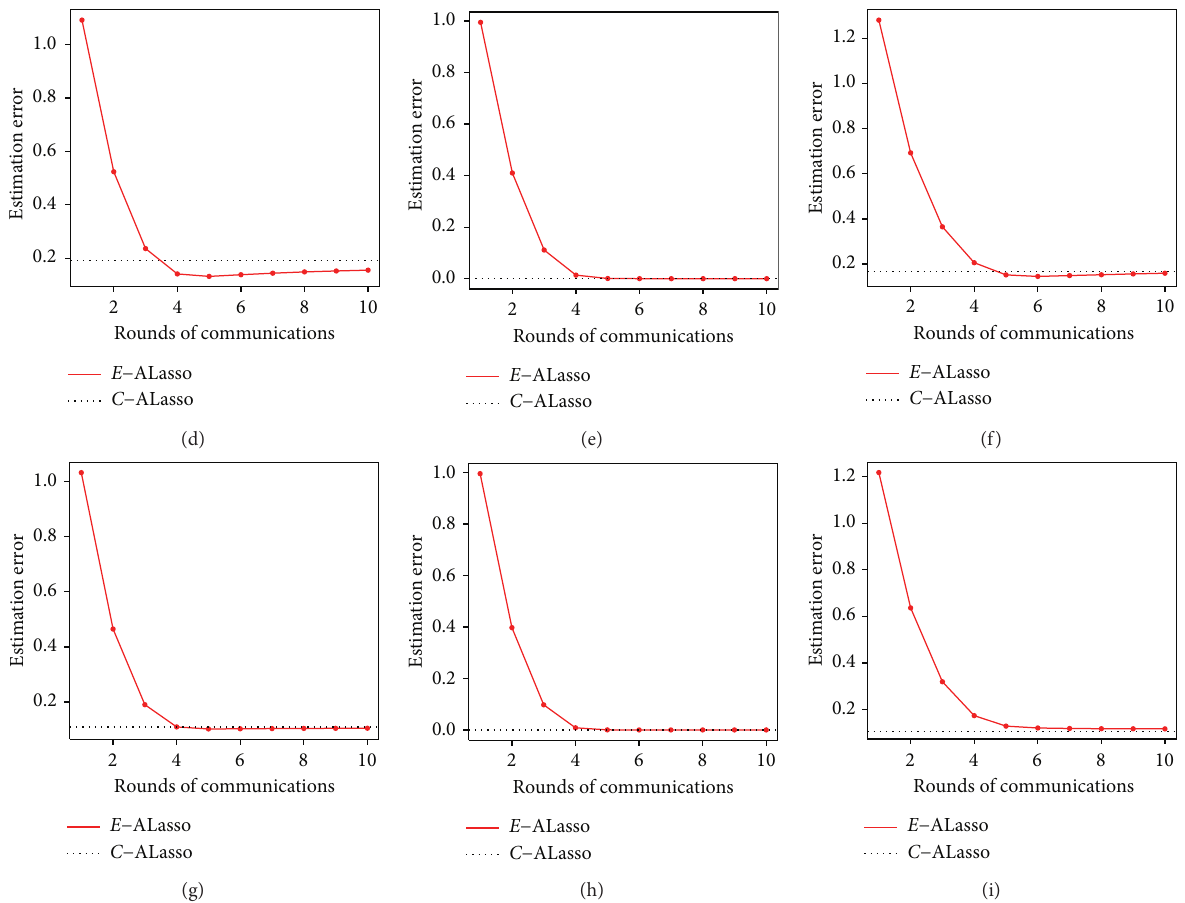
Figure 1: Comparison of two methods for the estimation error based on k � 50; the sparse ALasso penalized quantile regression. L ( 0 , 1 ) denote the Laplace ( 0 , 1 ) distribution. (a) N ( 0 , 1 ) , τ � 0 . 3. (b) N ( 0 , 1 ) , τ � 0 . 5. (c) N ( 0 , 1 ) , τ � 0 . 7. (d) t ( 2 ) , τ � 0 . 3. (e) t ( 2 ) , τ � 0 . 5.